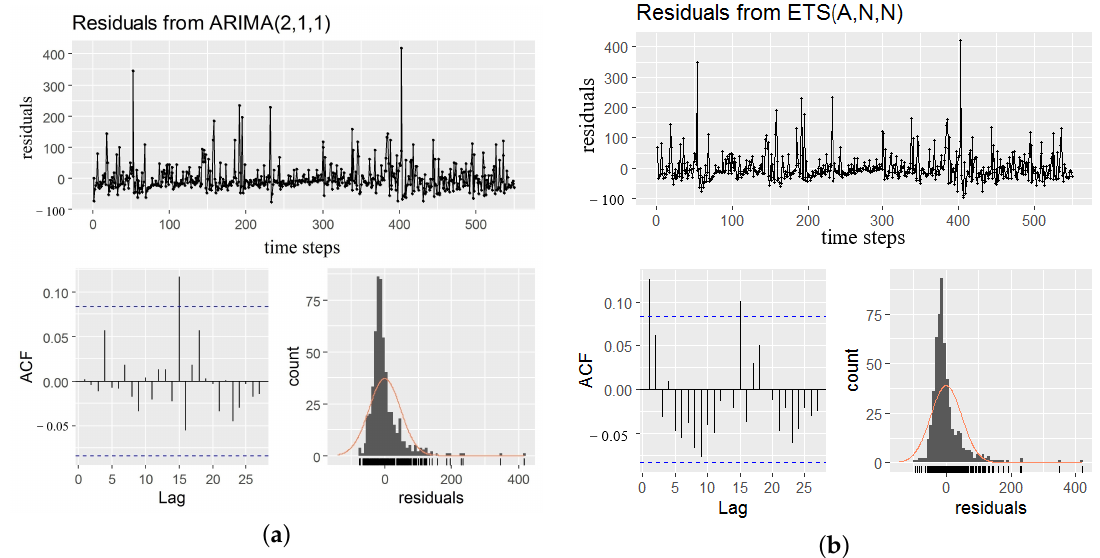
Figure 6. Comparisons between ARIMA and ETS models ( a ): ARIMA model, ( b ): ETS